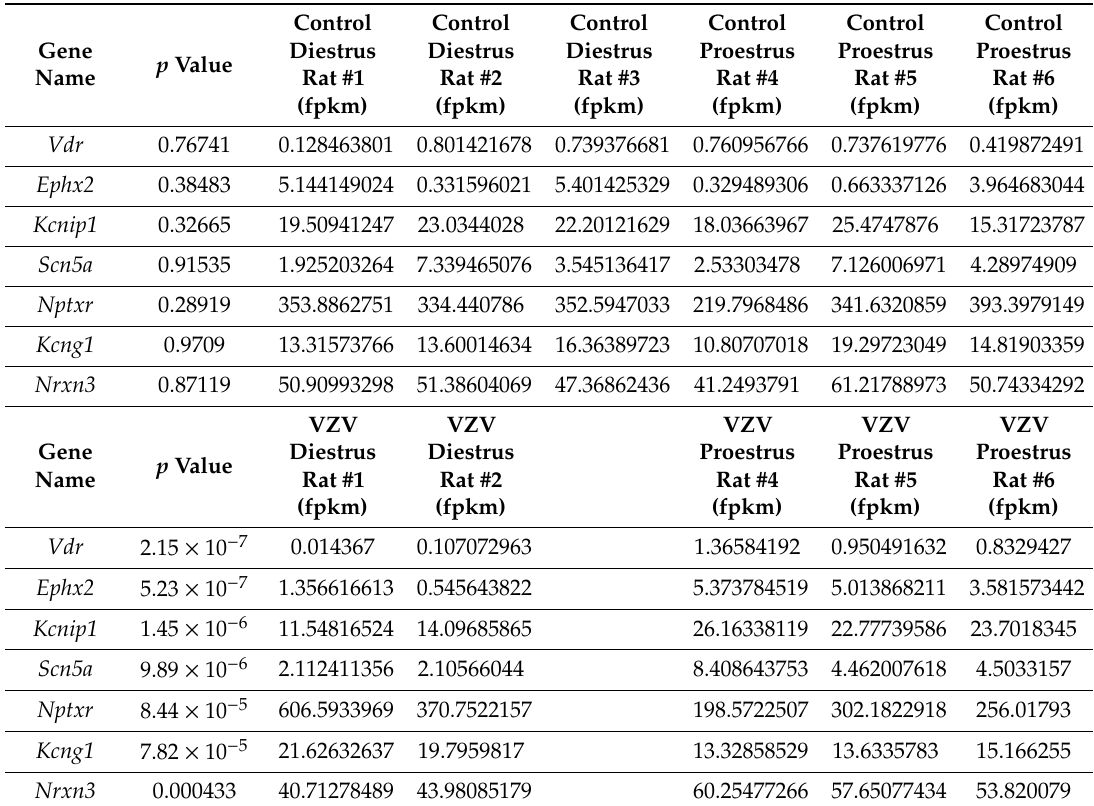
Table 3. RNA-seq gene expression in central amygdala after infection with saline or varicella zoster virus in cycling female